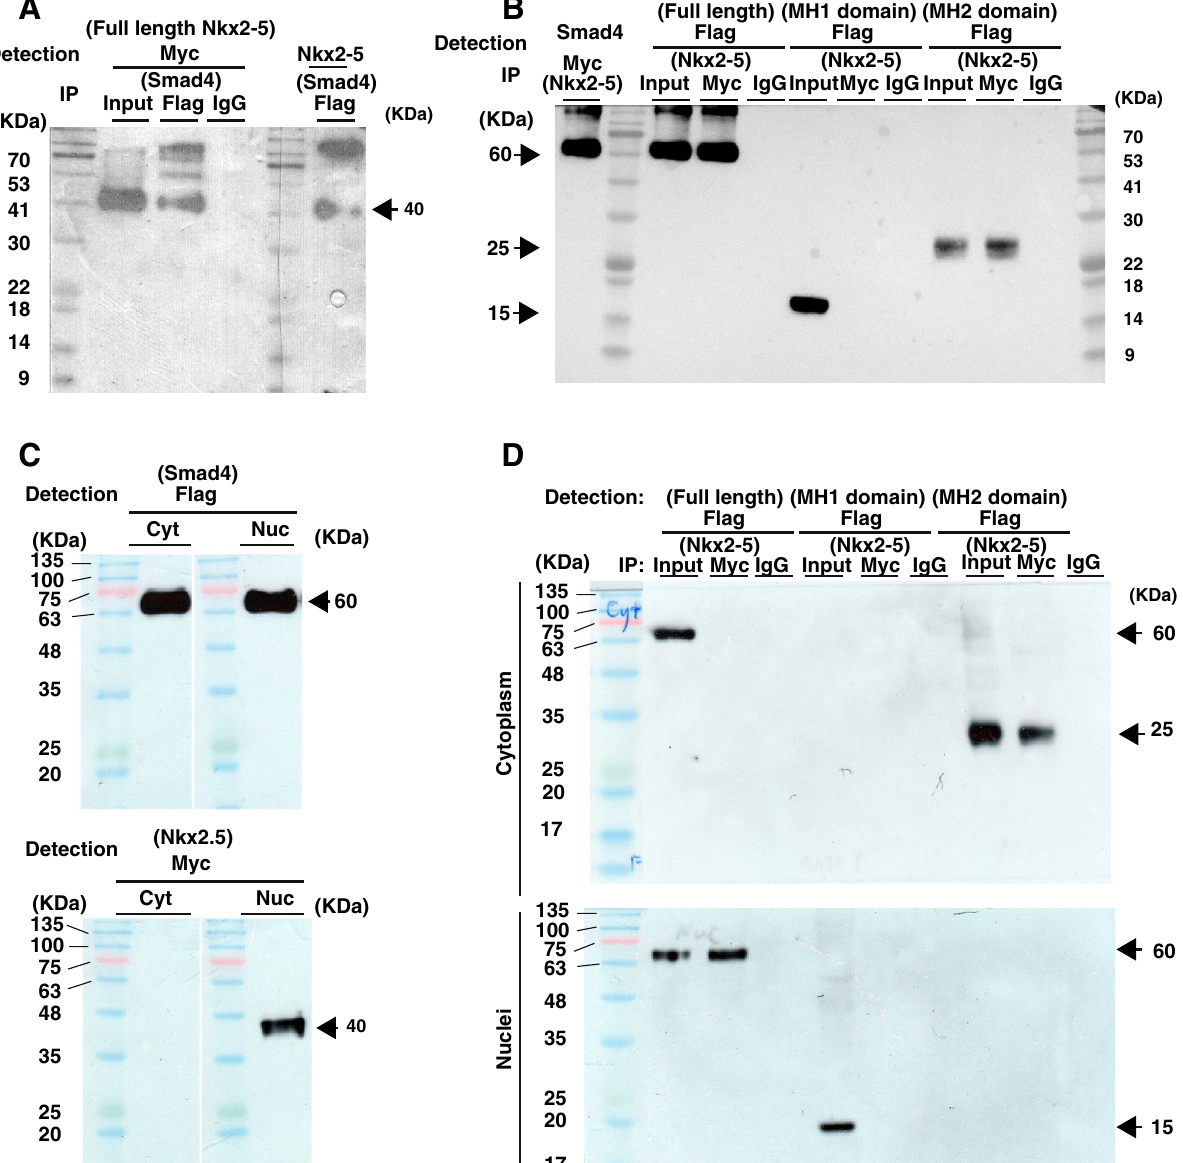
Figure 3. Interaction between Nkx2-5 and Smad4 via the MH2 domain. (A ) Myc-tagged Nkx2-5 was co-immunoprecipitated with Flag-tagged Smad4 and detected using anti-Nkx2-5- and anti-Myc-antibodies. ( B ) Flag-tagged Smad4, and MH1- and MH2- deleted versions, were co-immunoprecipitated with Myc- tagged Nkx2-5 and detected using anti-Smad4 and Flag-antibodies. Nkx2-5 interacts with the Flag-tagged MH2 domain but not the MH1 domain. ( C ) Subcellular distribution of Flag-tagged Smad4 (upper) and Myc-tagged Nkx2-5 (lower) was determined by western blotting for extracts subcellular fractionated from cytoplasm or nuclei. ( D ) Interaction of Myc-Nkx2-5 to Flag-Smad4 - full length, -MH1, or -MH2 is tested by Co-immunoprecipitation of extracts subcellular fractionated from cytoplasm or